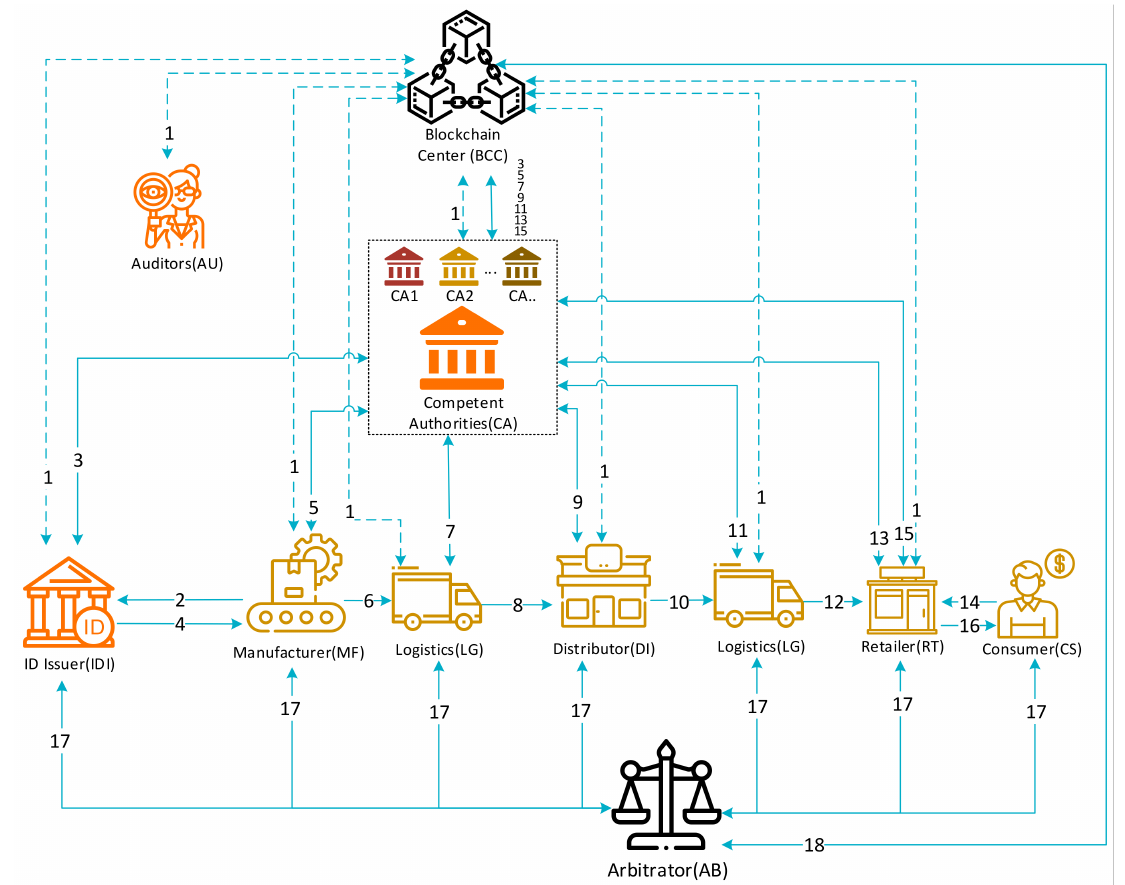
Figure 2. System architecture